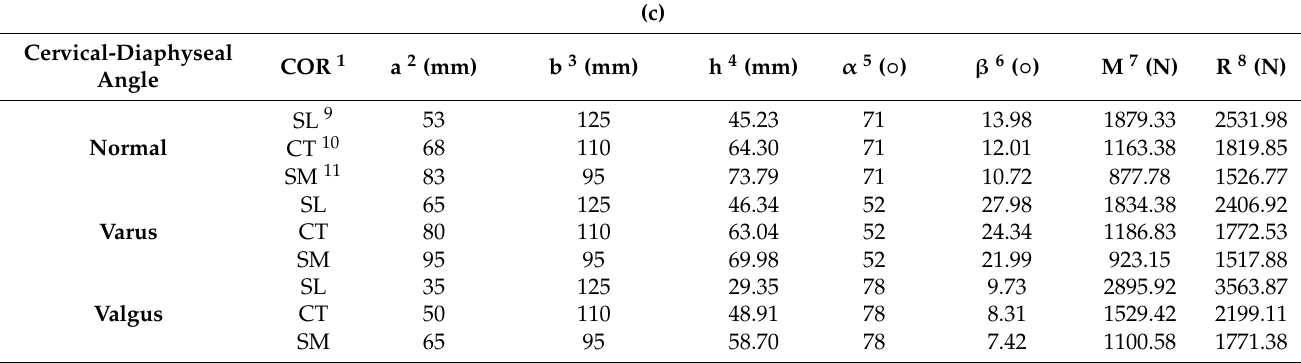
Medial COR location.